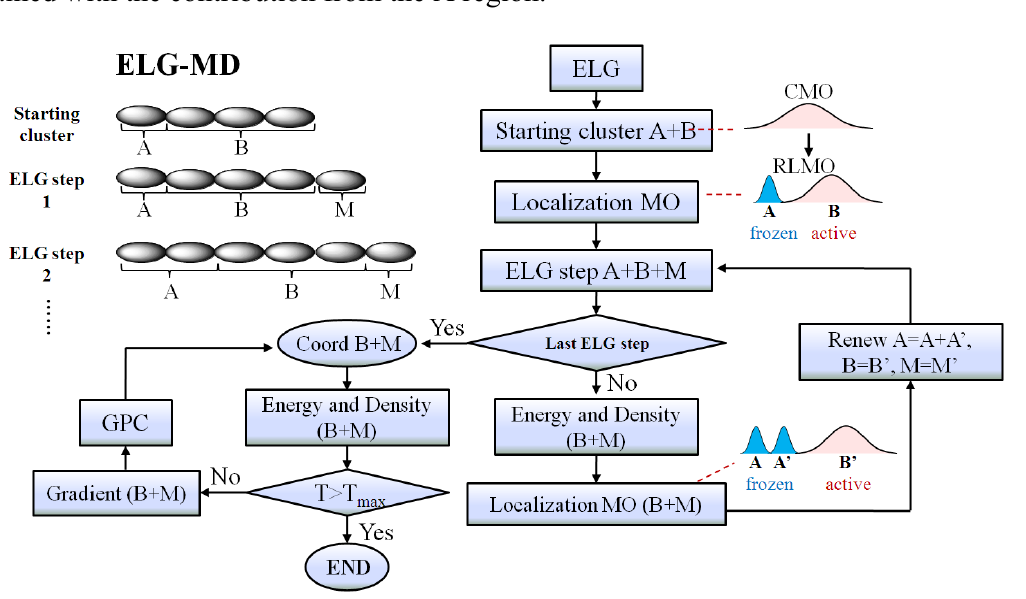
in β -strand conformation with 14 water molecules. (Gly) 14 , M and M regions for the ELG-MD procedures. The notations 1 2 3